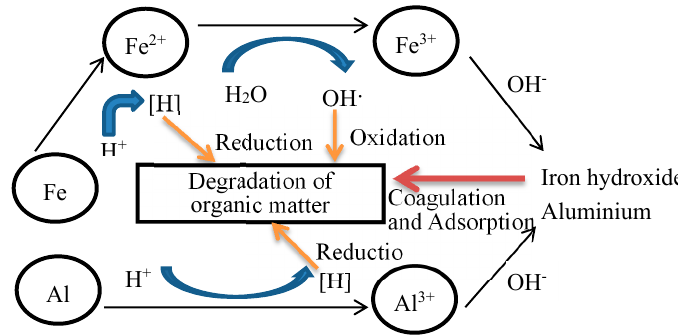
Figure 14. The reaction mechanism of Fe/Al/C multiple micro-electrolysis.